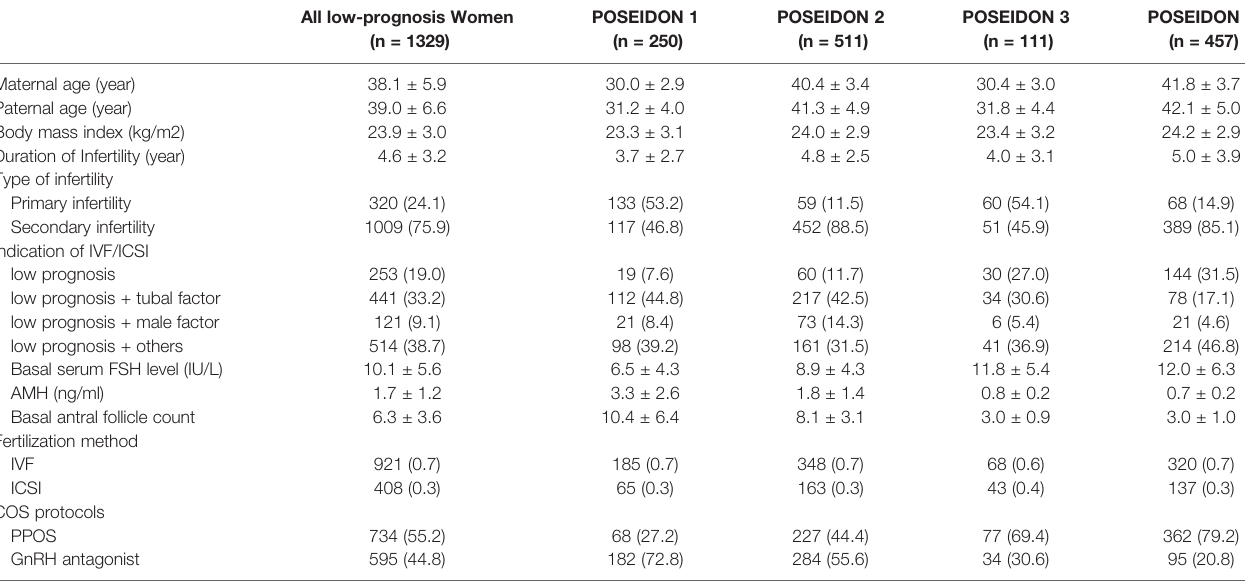
TABLE 1 | Baseline and cycle characteristics of low-prognosis women strati fi ed according to the POSEIDON criteria. All low-prognosis Women (n = 1329)